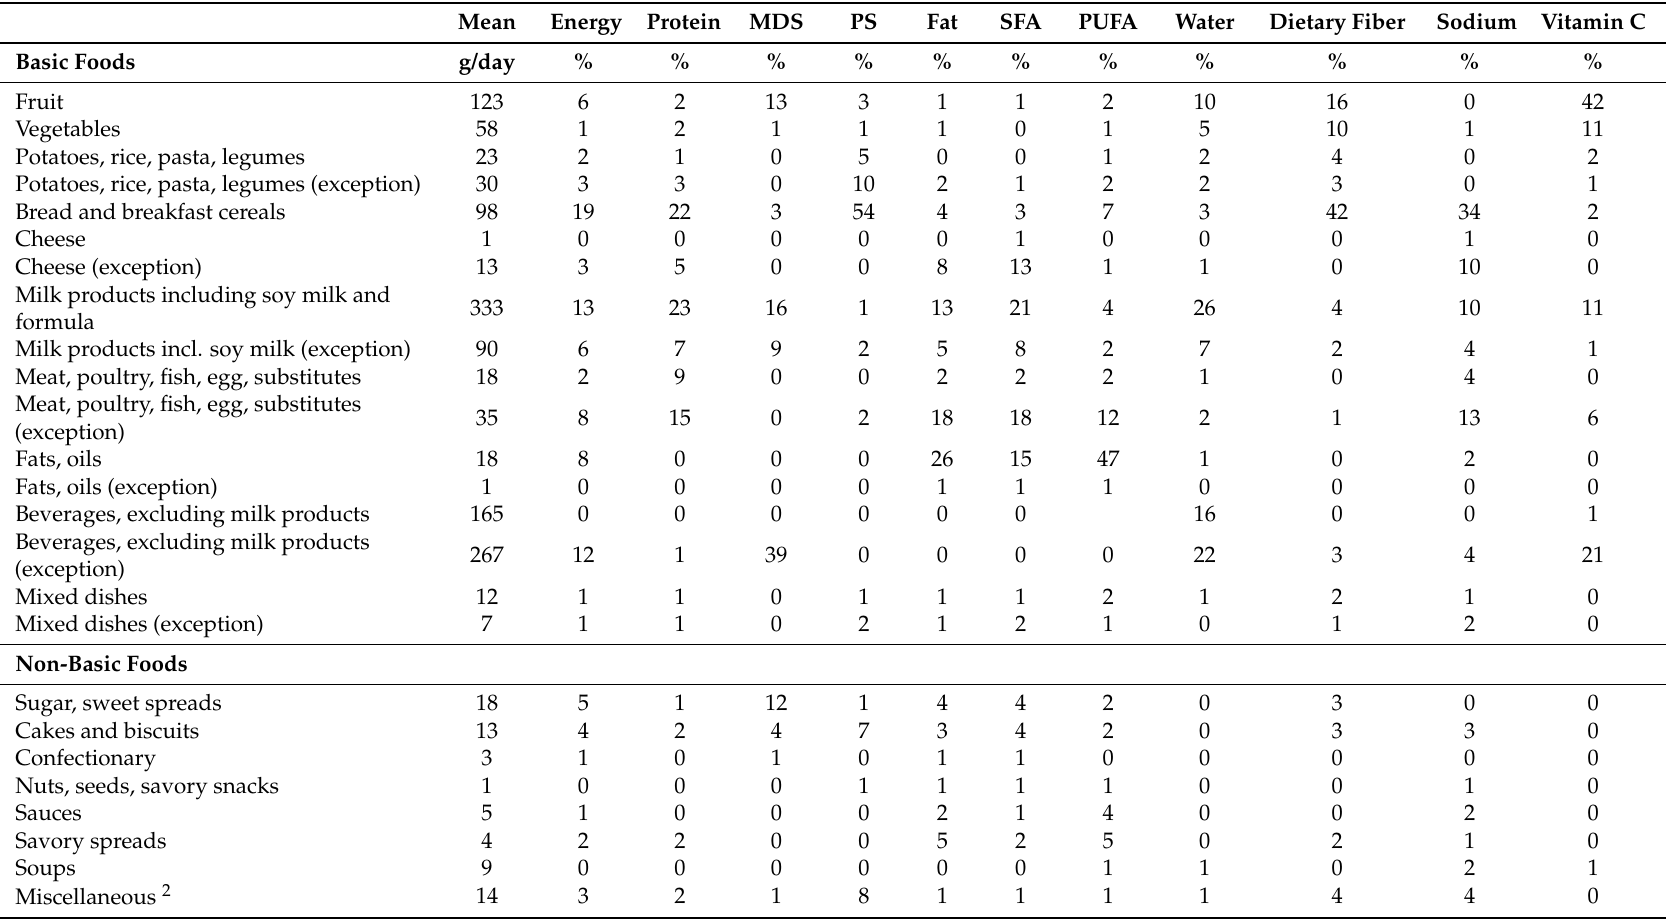
Table 4. Consumption of food groups 1 and their contribution to intake of selected nutrients among children 1–3 years